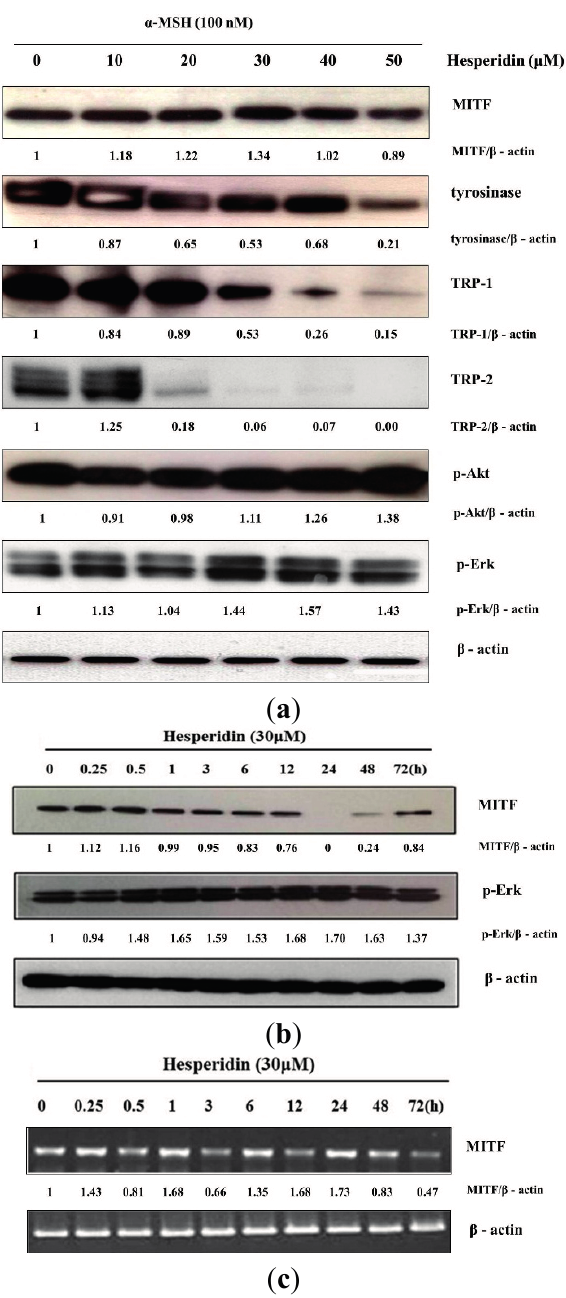
level of MITF at different time in the presence of 30 μ M hesperidin (Figure 2c). The mRNA level of MITF fluctuated without obvious decrease at 24 or 48 h post hesperidin treatment.